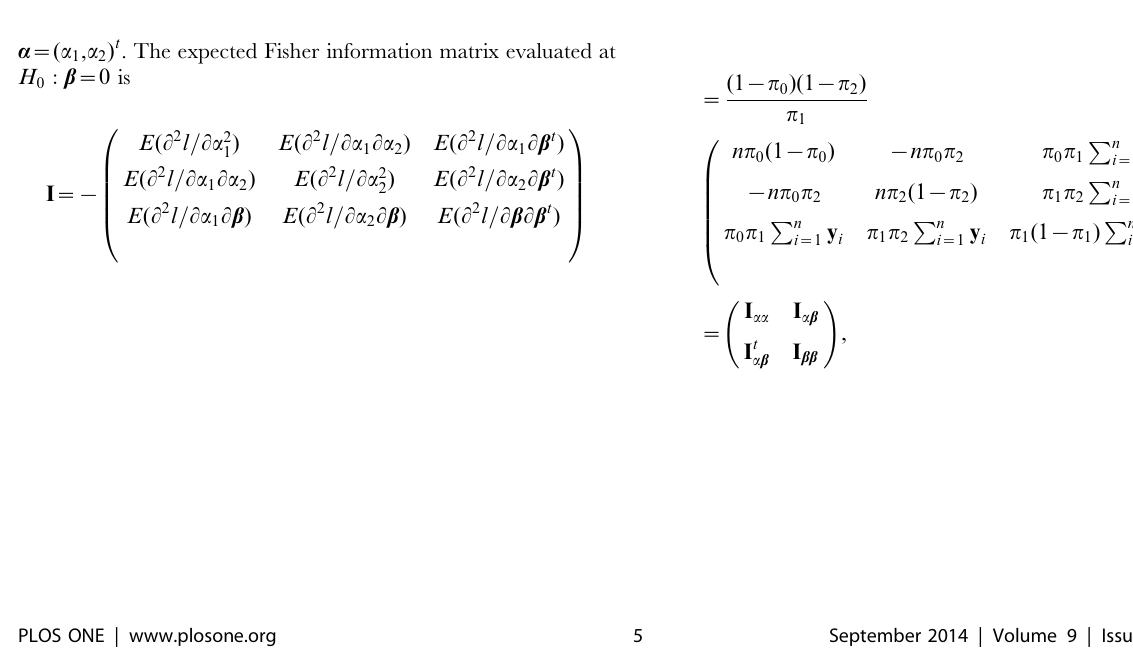
Figure 1. Simulated power for recessive model. The relative genotype risks are f 1 = f 0 ~ 1, f 2 = f 0 ~ 1 : 5 . K represents disease prevalence and p is the frequency of allele a . The abbreviations for the test statistics are the same as in Table 2.